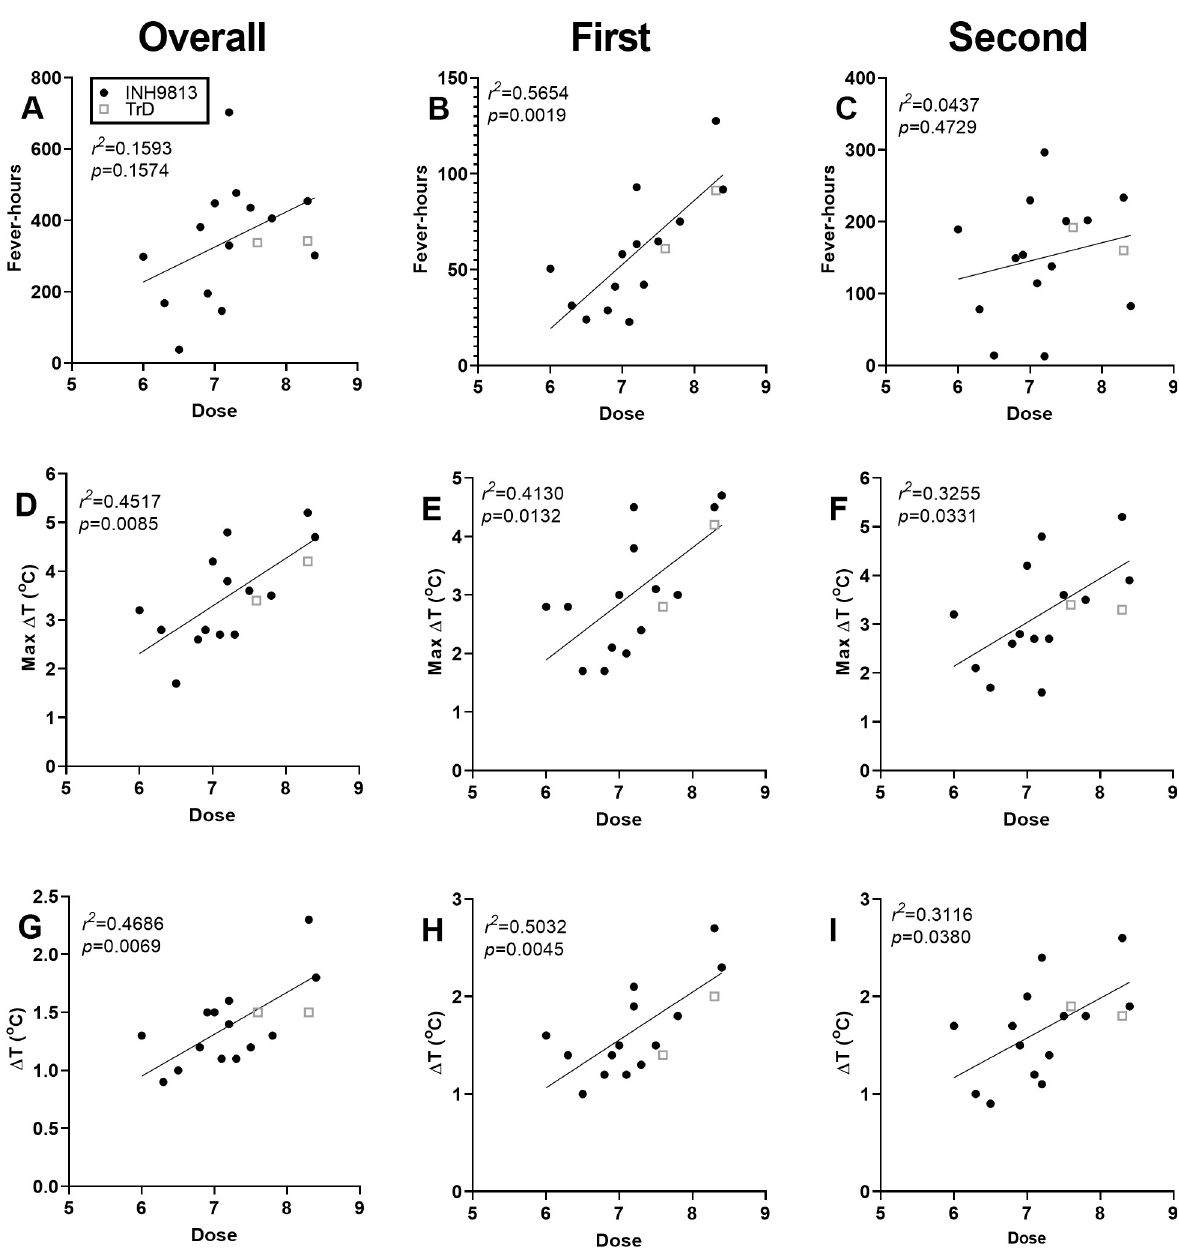
Fig 2. Correlation between dose and fever is strongest for the first febrile period. (A, B, C) Fever-hours, the sum of the significant elevations divided by four to convert to hours. (D, E, F) Maximum temperature deviation from pre-infection baseline for each individual animal. (G, H, I) Average temperature elevation above baseline.(A, D, G) Overall post-exposure period, (B, E, H) first febrile period, 0.5–2 dpi, (C, F, I) second febrile period, 2.5–8 dpi.